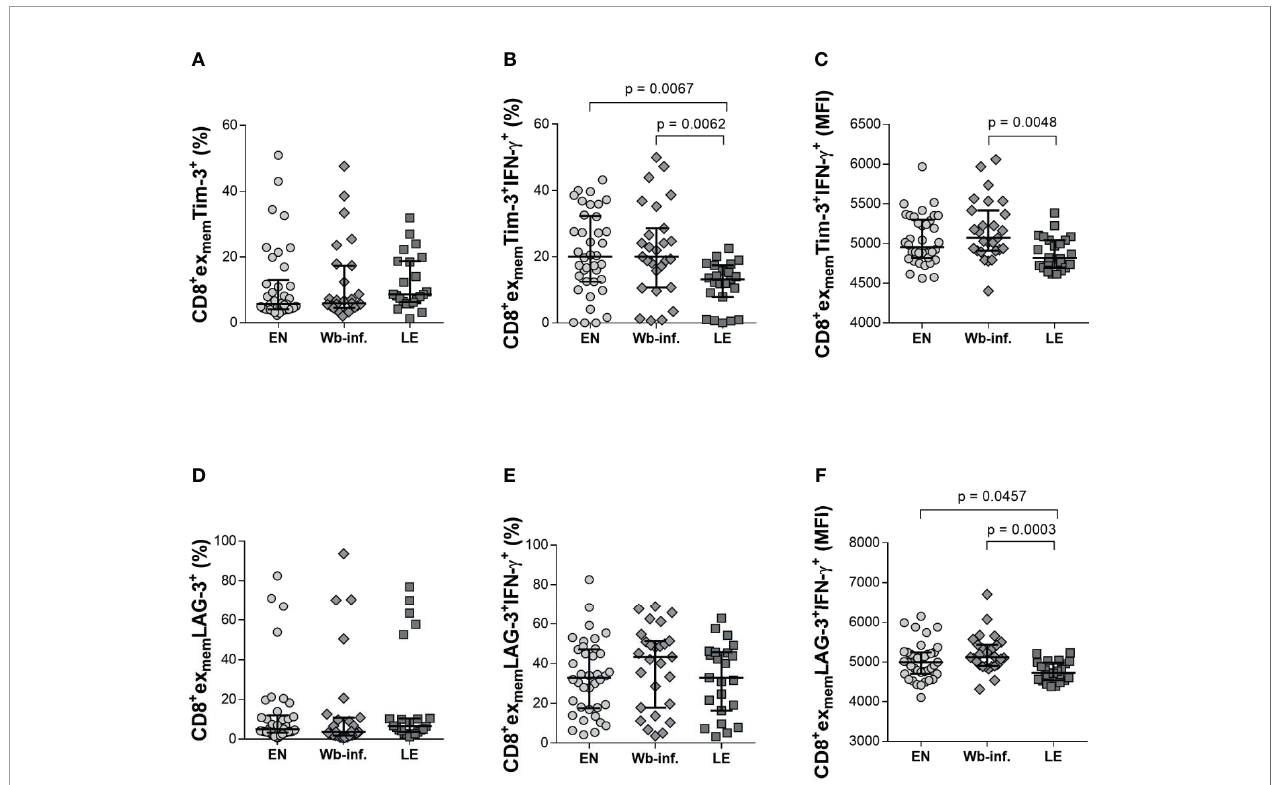
FIGURE 3 | Decreased levels of IFN- g in CD8 + ex mem T-cell subsets expressing either Tim-3 + and LAG-3 + in lymphedema patients. Cell populations were analyzed according to the applied gating strategy ( Supplementary Figure S3 ). To determine the exhaustion state of speci fi c immune cells, Tim-3 (A – C) and LAG-3 (D – F) on CD8 + ex mem cell subsets were analyzed in PBMC fractions from endemic normals (EN, n = 38), Wuchereria bancrofti infected (Wb-inf., n = 27), and participants displaying lymphedema pathology (LE, n = 23). In addition, subsets were analyzed regarding their ability to produce IFN- g (frequencies [median and IQR] shown in (B, E) and median fl uorescence intensity (MFI) counts in (C, F) . Symbols in graphs show data points with median and IQR. Statistical signi fi cances between the groups were obtained using Kruskal-Wallis followed by Dunn ’ s multiple comparison post hoc